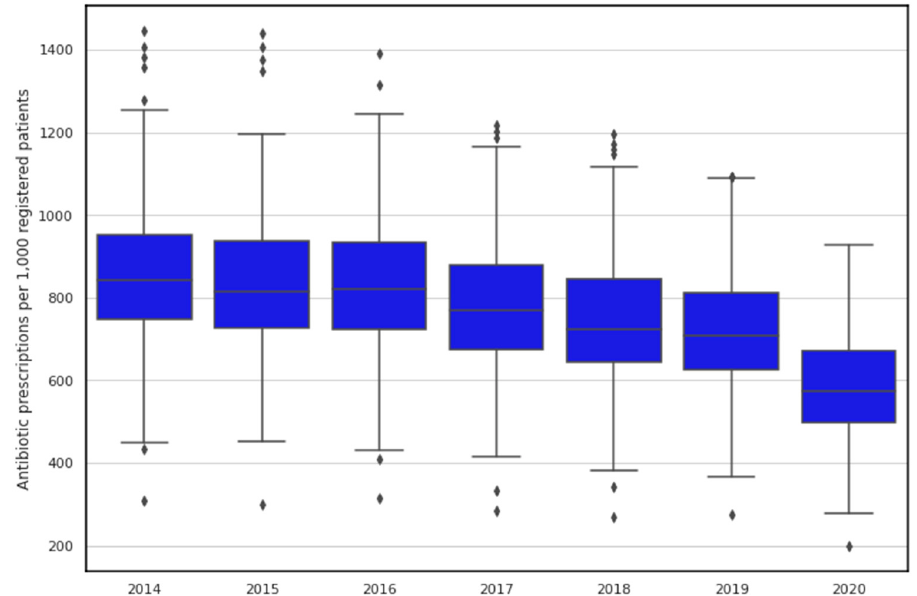
Figure 1. Temporal changes and variation in antibiotic prescribing rates in Northern Ireland. Hori-